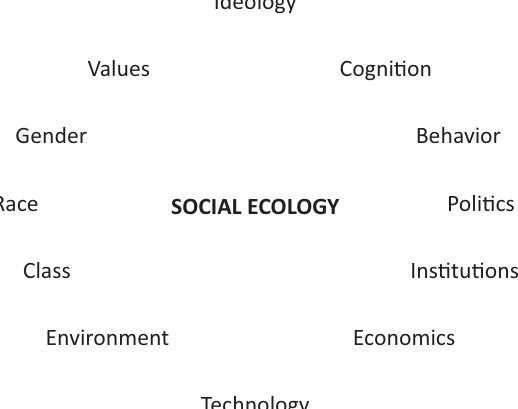
Figure 2. Socio-ecological factors affecting climate policy in